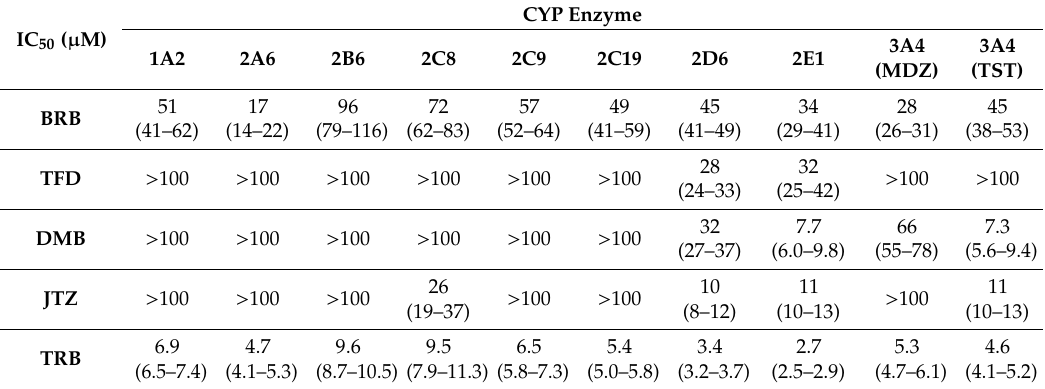
Table 2. IC 50 values of BRB, TFD, DMB, JTZ and TRB against CYP enzymes in pooled